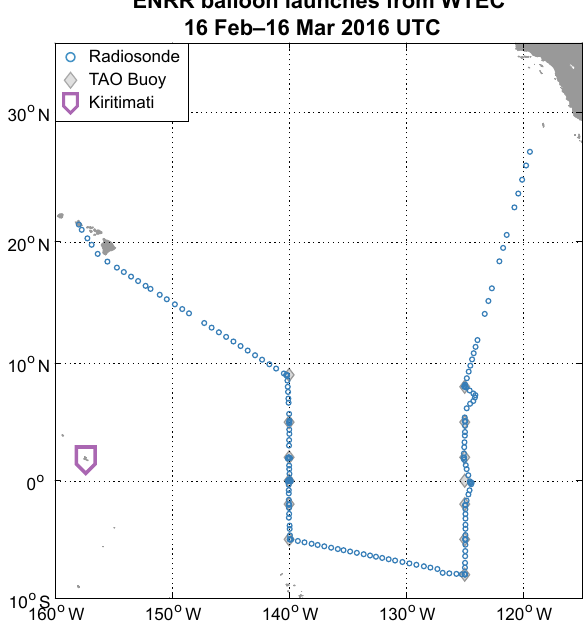
Figure 3. The release locations of all rawinsonde observa- tions collected by NOAA Ship Ronald H. Brown during ENRR, 16 February–16 March 2017. Colors from www.ColorBrewer.org by Cynthia A. Brewer, Geography, Pennsylvania State